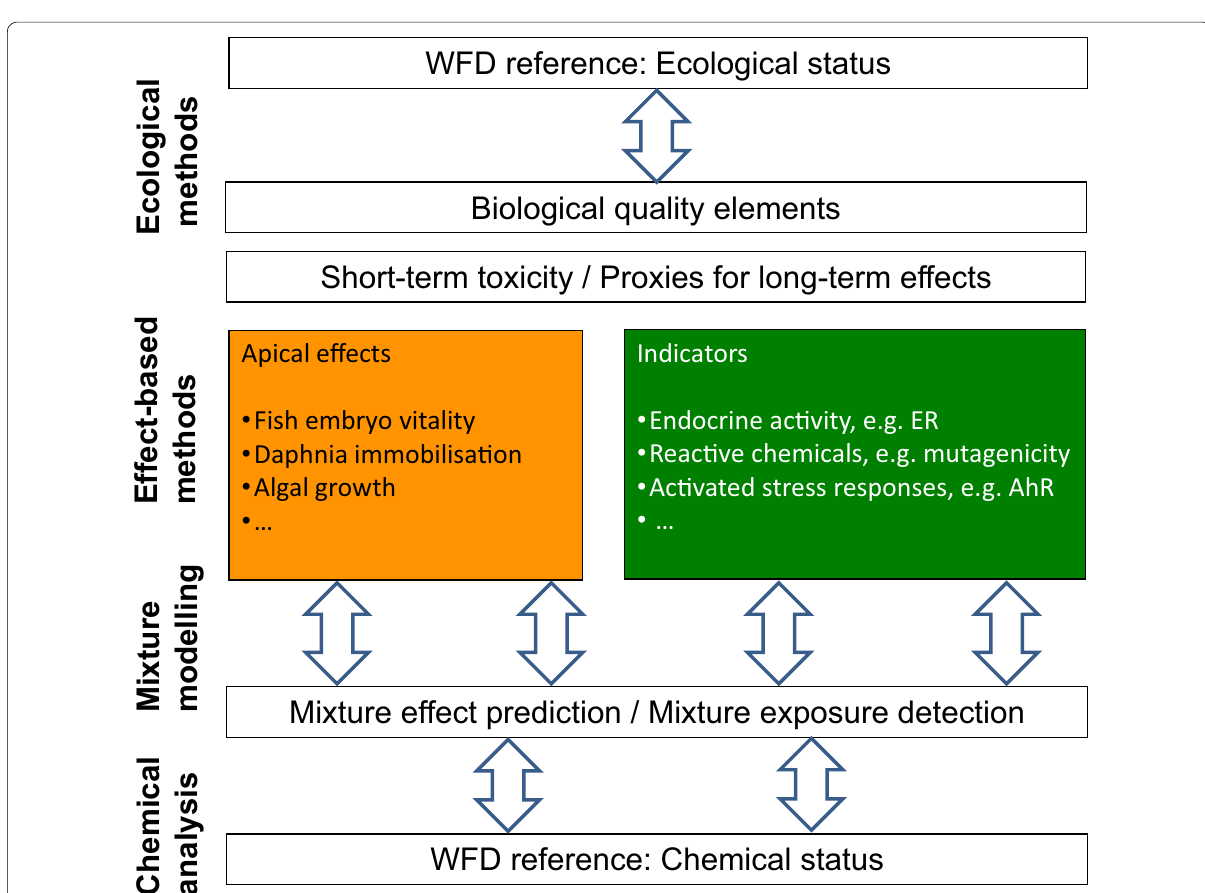
Fig. 5 Effect‑based methods for water monitoring and its complementarity to chemical and ecological observations. The analysis of RBSPs would follow the same assessment approach, but is reported under the WFD ecological status. This figure extends concepts from Brack et al. (in press)